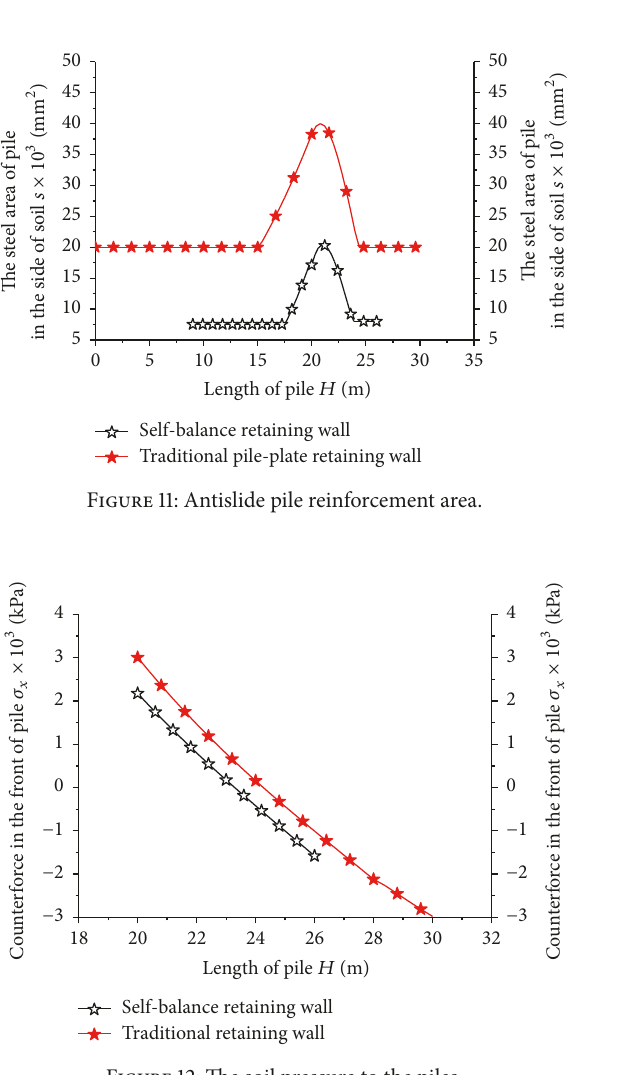
Figure 12: The soil pressure to the piles.